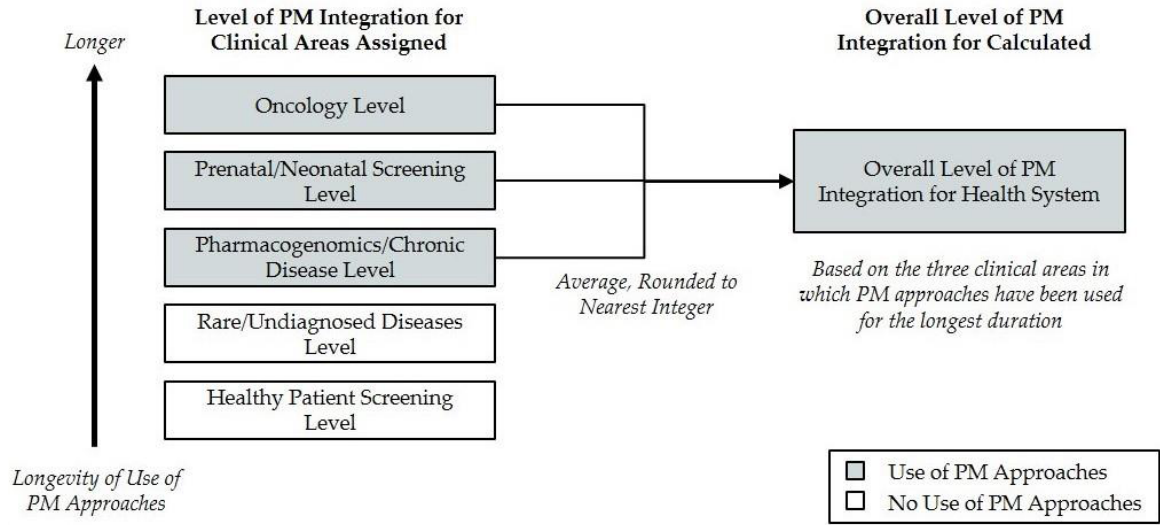
Figure 2. Example assessment of the overall level of personalized medicine integration for a health system.